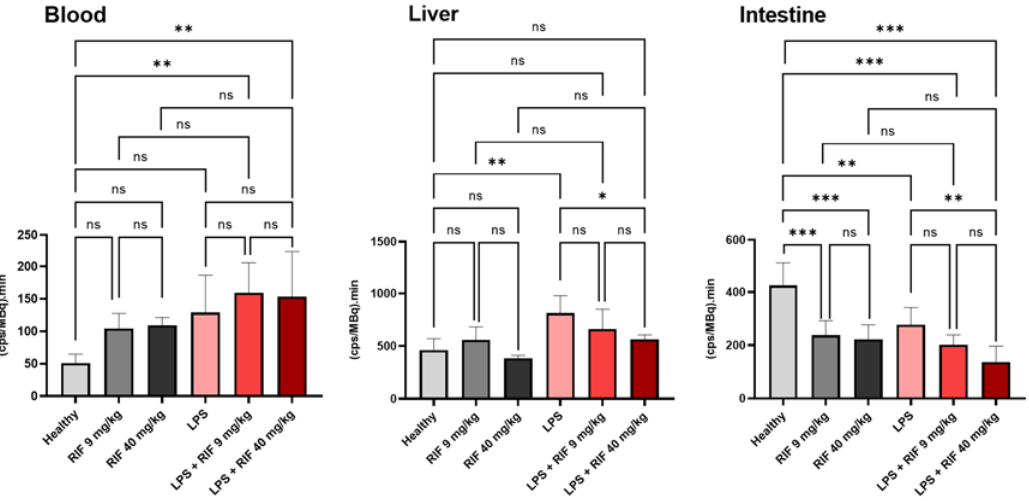
Figure 4. Area under the time–activity curves (AUC) of 99m Tc-mebrofenin in the blood pool (imaged- derived), liver, and intestine obtained in healthy ( n = 5 per group) and in lipopolysaccharide (LPS)- treated rats ( n = 6 per group). Impact of pre-treatment with 9 or 40 mg/kg of rifampicin (RIF), a potent Oatp/Mrp2/Mrp3 inhibitor is reported. Radioactivity is expressed in counts per second (cps) in each region of interest, normalized to the injected radioactivity amount in each animal (cps/MBq). Data are mean ± SD. * p < 0.05, ** p < 0.01, *** p < 0.001, ns indicates not significant, ordinary one-way ANOVA followed by a Tukey’s post hoc test for multiple comparison. LPS: lipopolysaccharide; RIF: rifampicin. Data obtained in the healthy and RIF 40 mg/kg groups have already been presented in a previous study